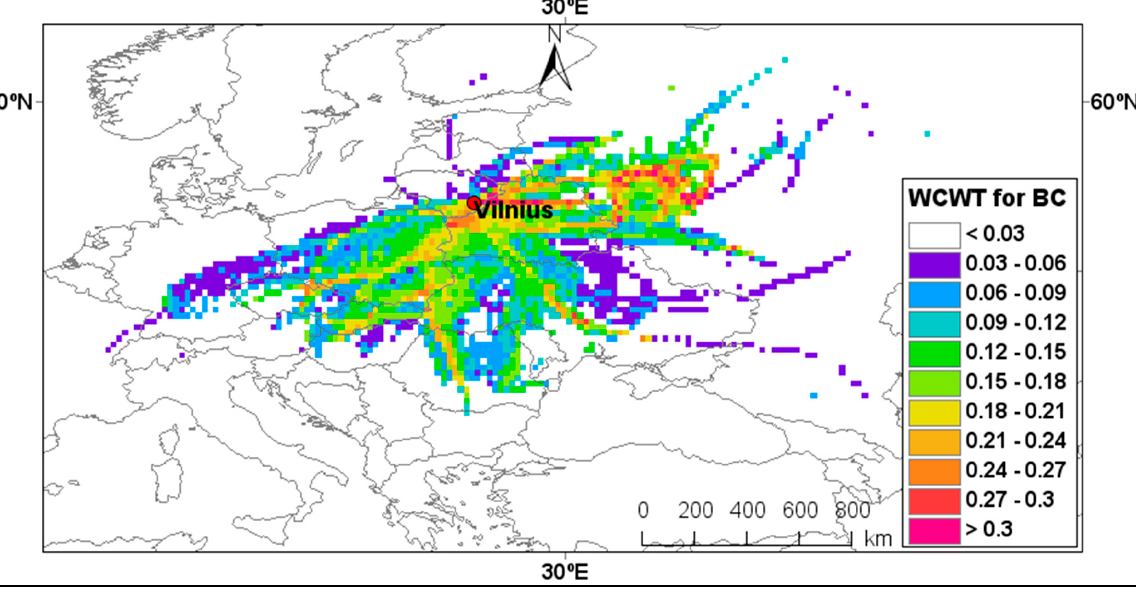
Figure 10. Weighted concentration weighted trajectory of BC in Vilnius in January and February 2014.